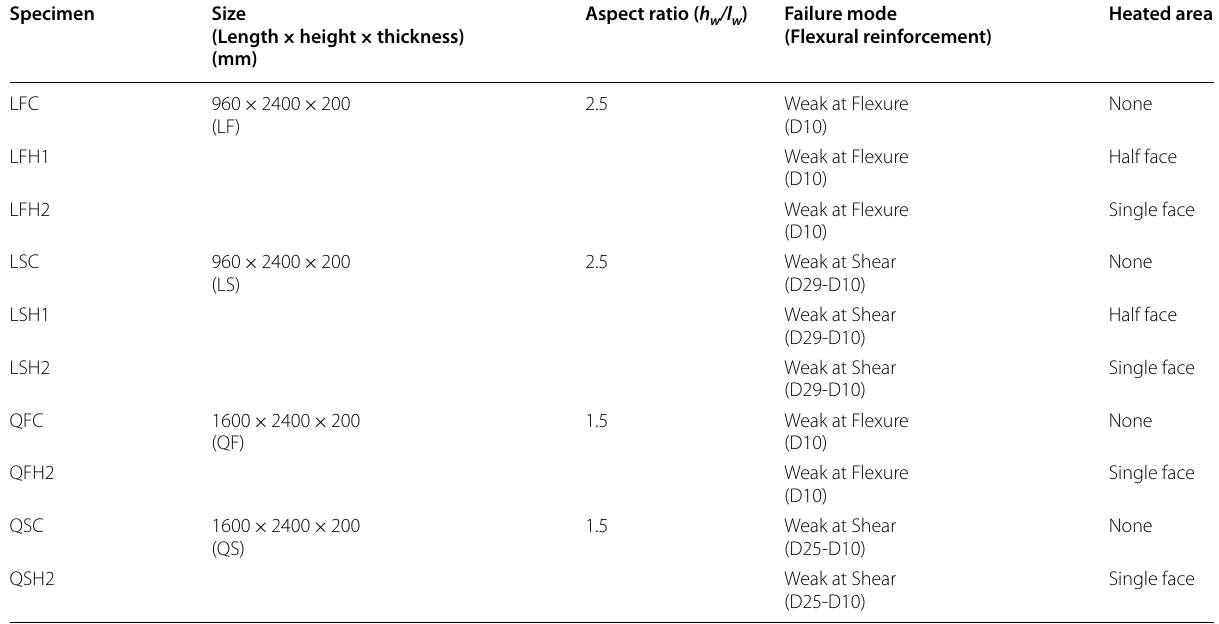
Table 1 List of specimens.